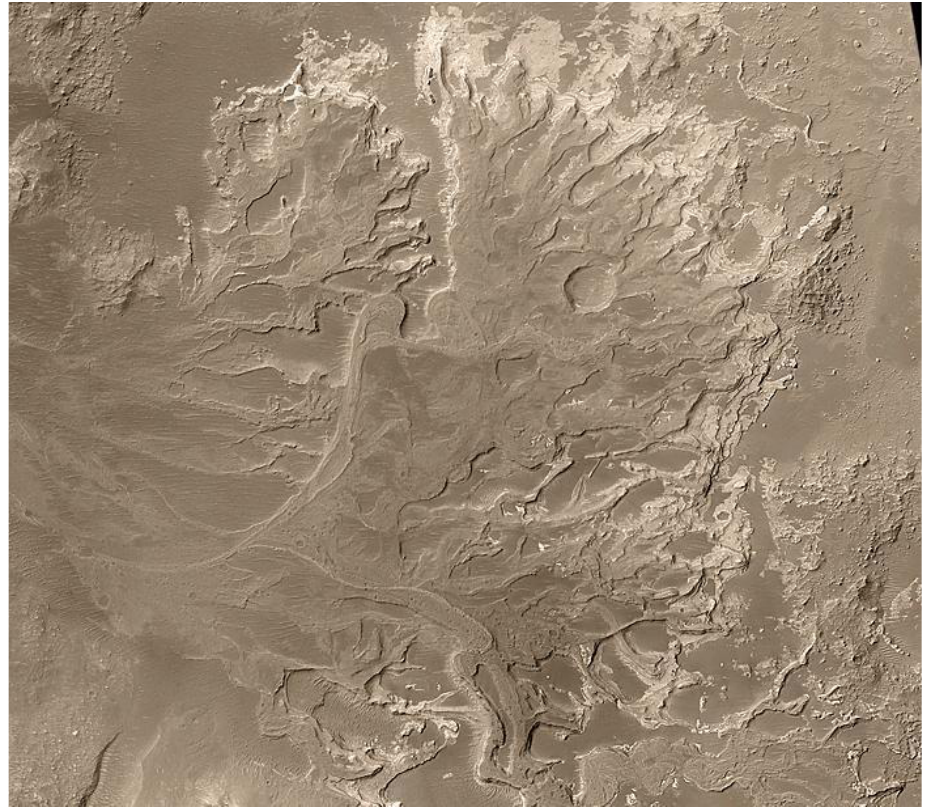
Figure 6. Delta in Eberswalde crater.